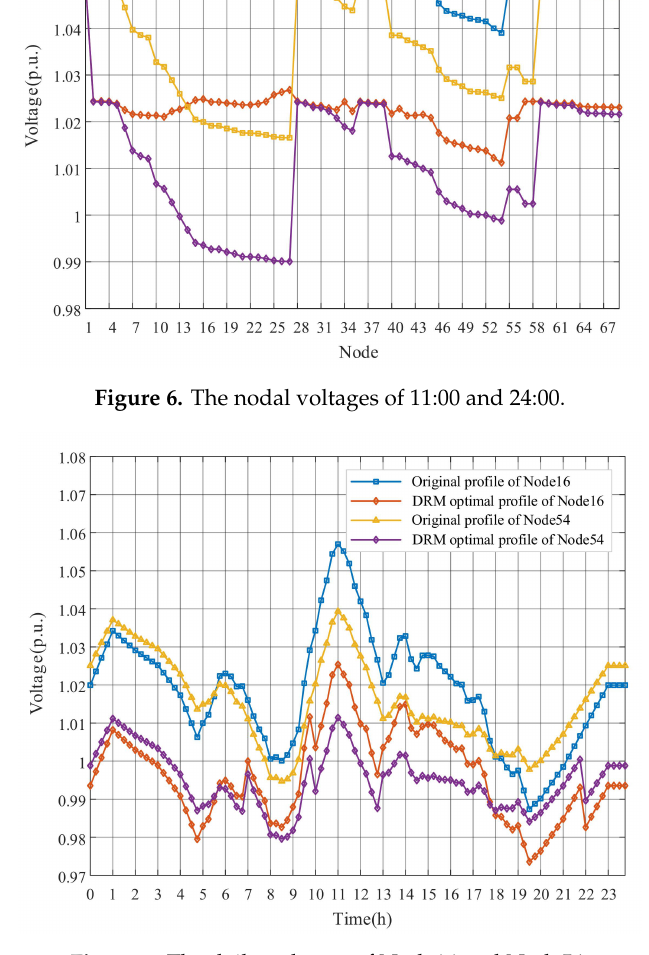
Figure 7. The daily voltages of Node16 and Node54.